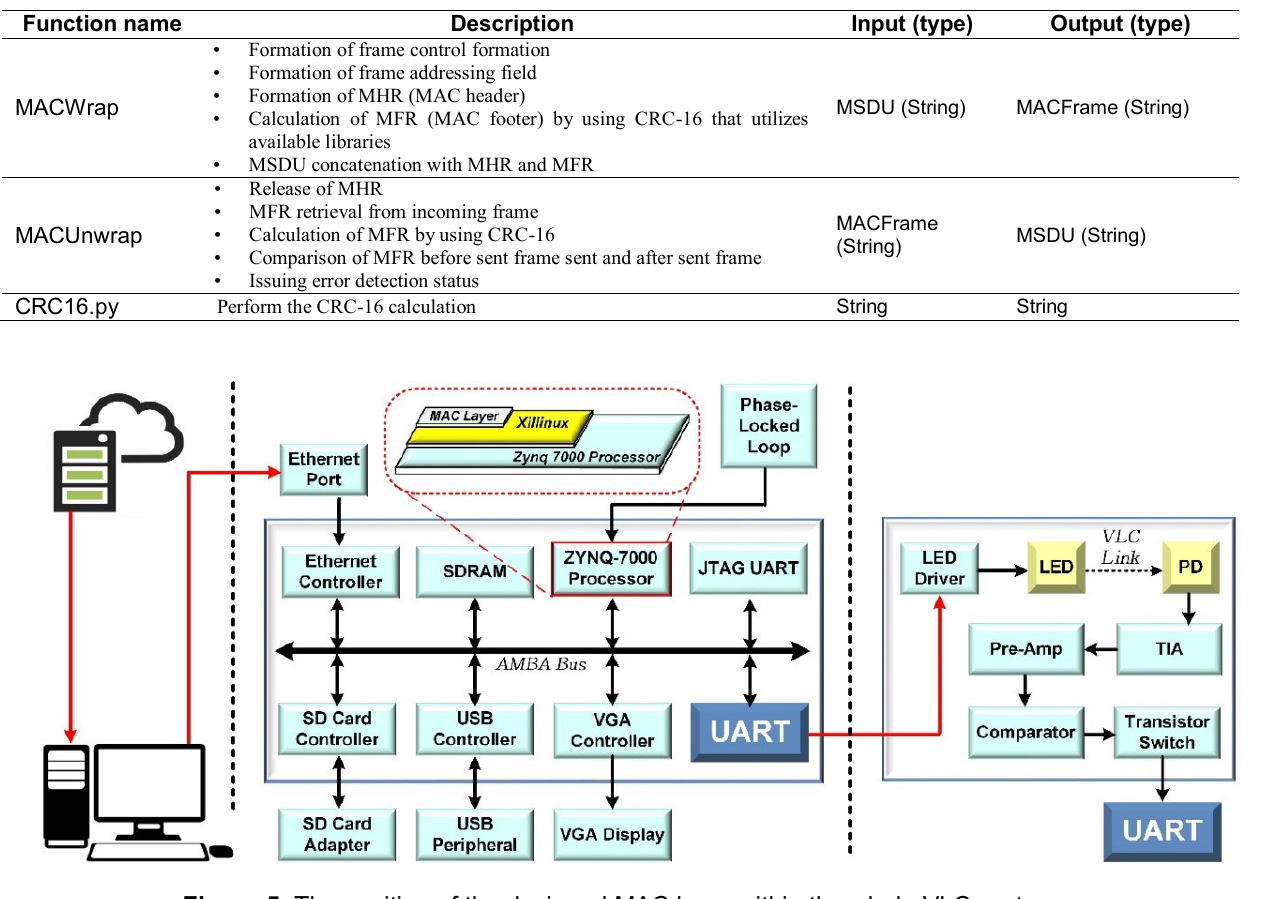
Figure 5 . The position of the designed MAC layer within the whole VLC